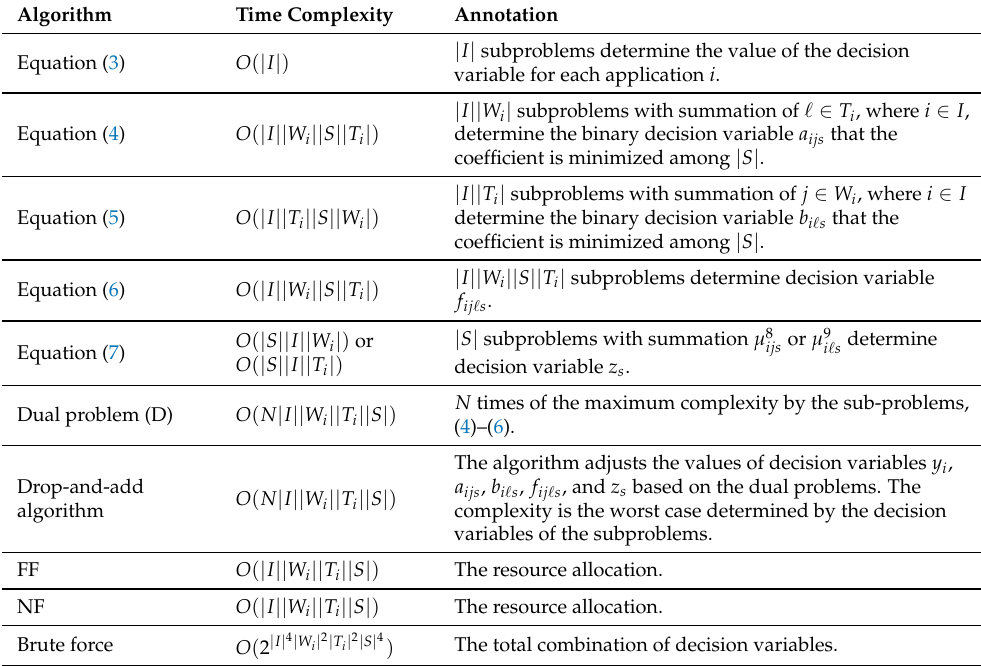
Table 10. Time complexity comparison between the proposed LR-based approach and other